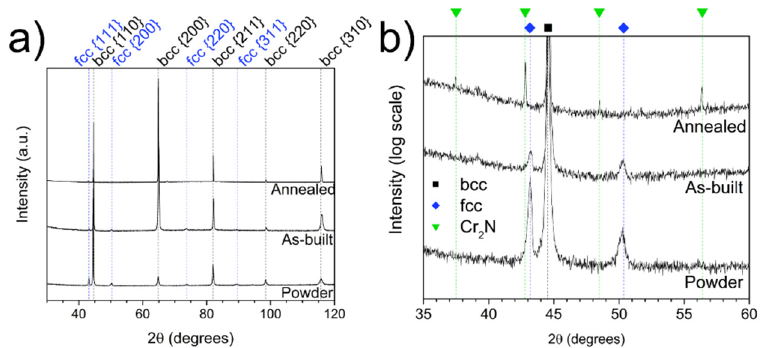
Figure 4. ( a ) XRD patterns of the feedstock powder, as-built and annealed samples. ( b ) XRD patterns shown with a logarithmic scale to emphasize the precipitating phases.